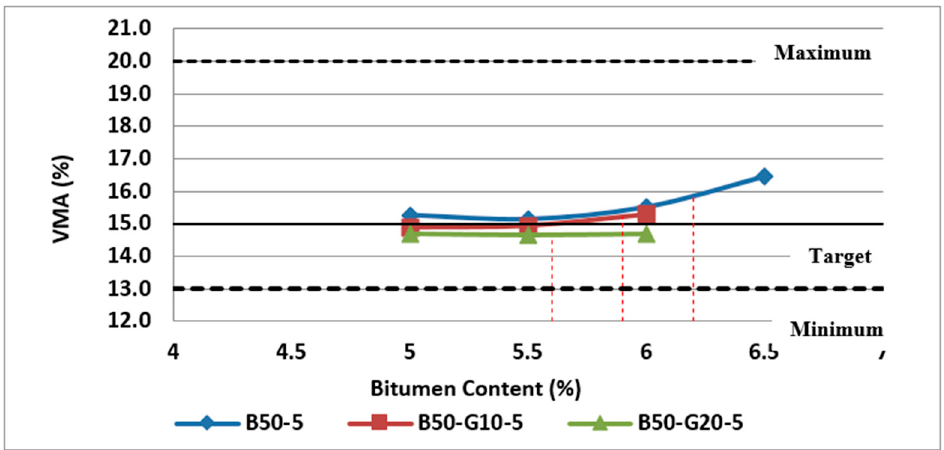
Figure 13. Effect of bitumen content and glass content on VMA of Mix II containing 25% RCA without glass and Mix IV and Mix V containing 25% RCA as coarse aggregate and glass as fine aggregate.